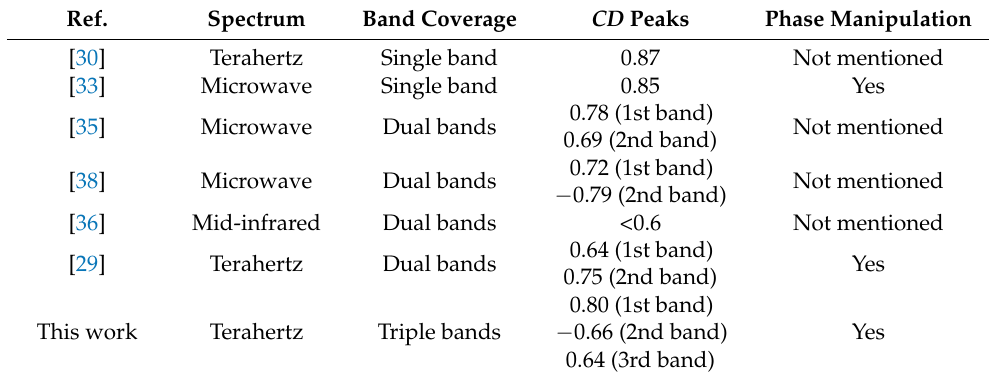
Table 2. Comparison of our work with previously reported reflective metasurfaces with CD properties. Ref. Spectrum Band